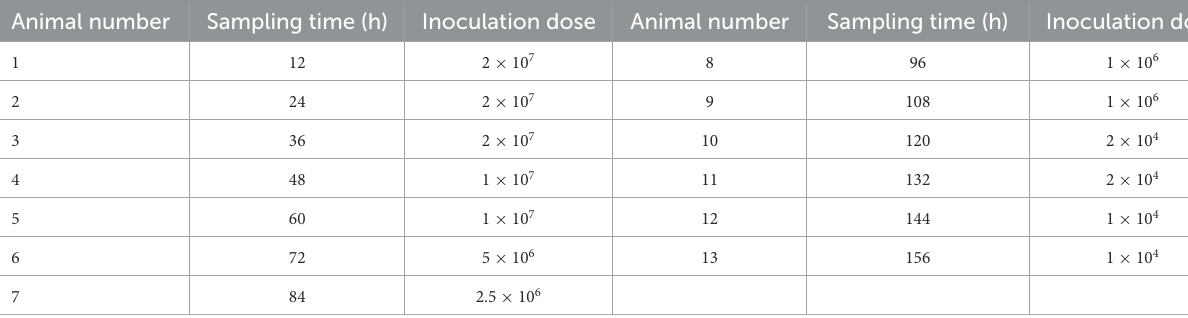
TABLE 2 Experimental design of the drug sensitivity study. Group Drug Dosage and days of